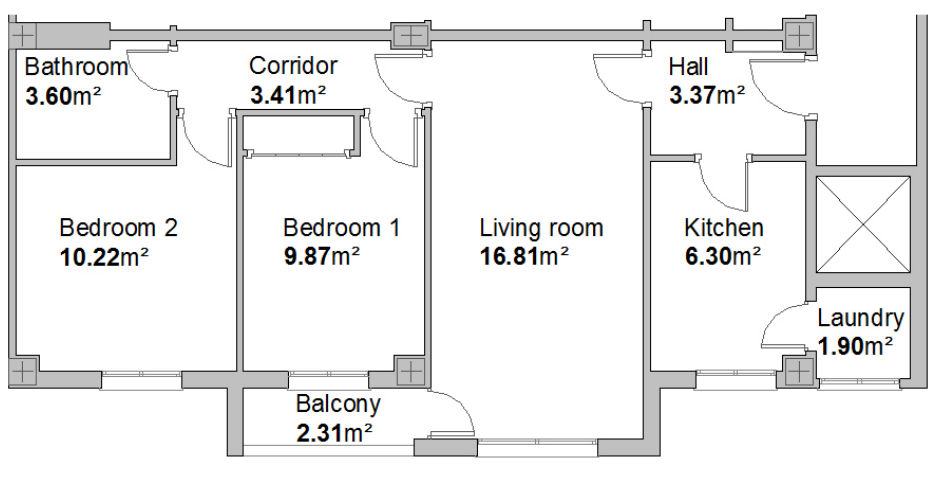
Figure 2. Floor plan of the typical dwelling unit